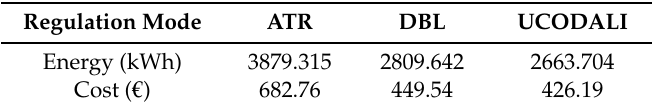
Table 3. Estimated consumption (energy and cost) for 1-year operation.